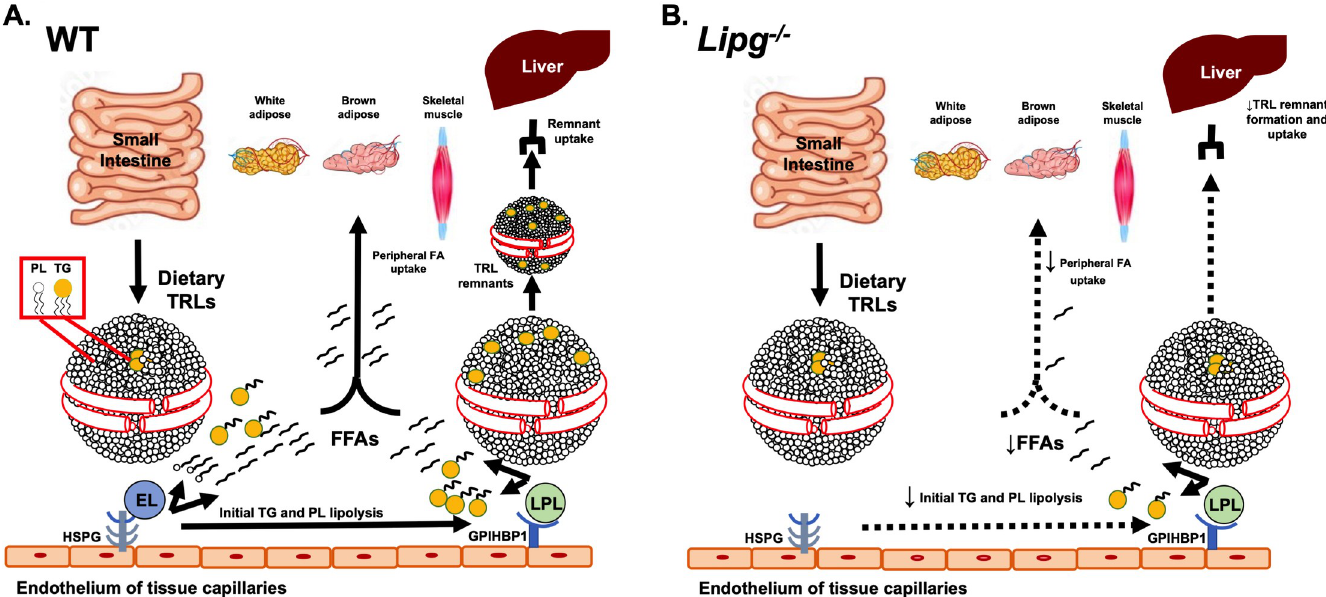
Fig 8. Schematic of role of EL in TRL catabolism. A-B. In the setting of EL expression (A), phospholipid lipolysis on TRL in postprandial or high fat-fed state allows for synergistic and efficient TG lipolysis by LPL, which promotes FA and TRL remnant uptake by the liver. Multiple FAs including long chain PUFAs are internalized by the liver. In EL-deficient mice (B), lipolysis of phospholipids on the outer shell of TRLs is impaired, resulting in less efficient access of LPL to TRL TGs and reduced TG lipolysis and remodeling of TRLs to smaller remnants, thus reducing TRL remnant uptake by the liver. In addition, the lack of ability of EL to catalyze lipolysis of phospholipids containing its preferred substrates of long chain PUFAs results in decreased PUFA uptake by the liver.